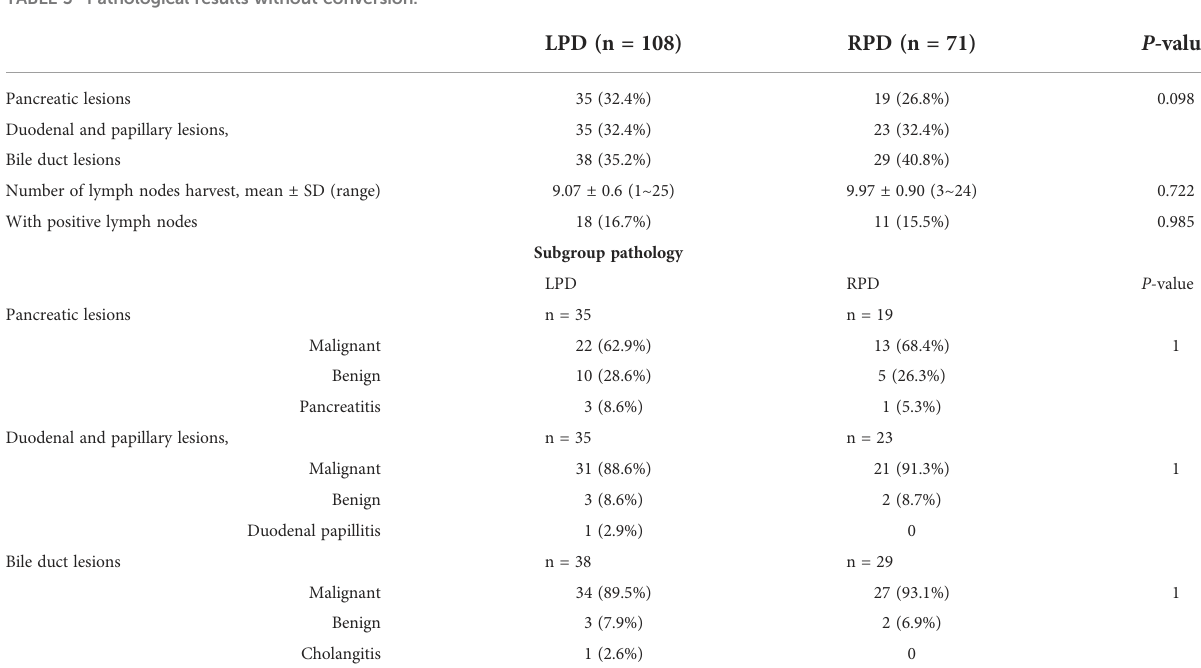
TABLE 3 Pathological results without conversion.